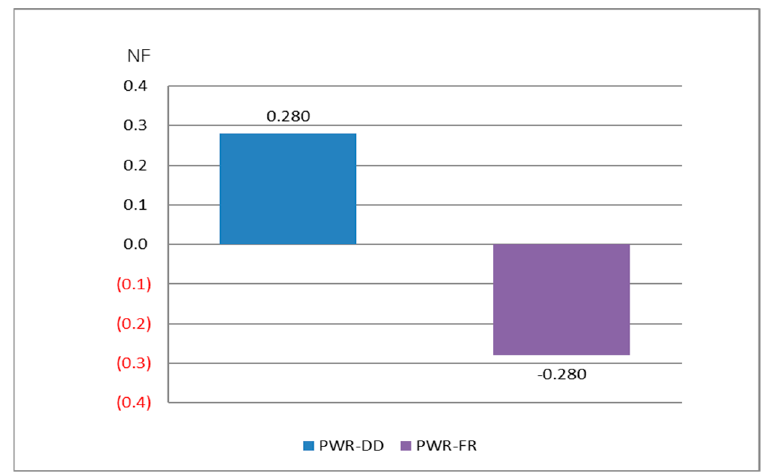
Figure 8. MCDM results using PROMETHEE and rank weights.